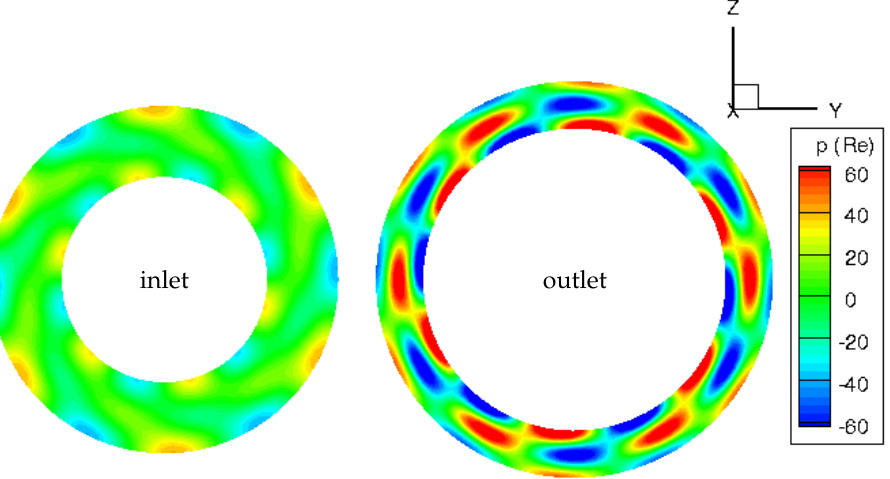
Figure 10. Real part of complex pressure in [Pa] for tonal RSI noise at inlet ( left ) and outlet ( right ) plane. 2nd BPF (1333.33 Hz). The modal structure of the sound field is clearly visible.